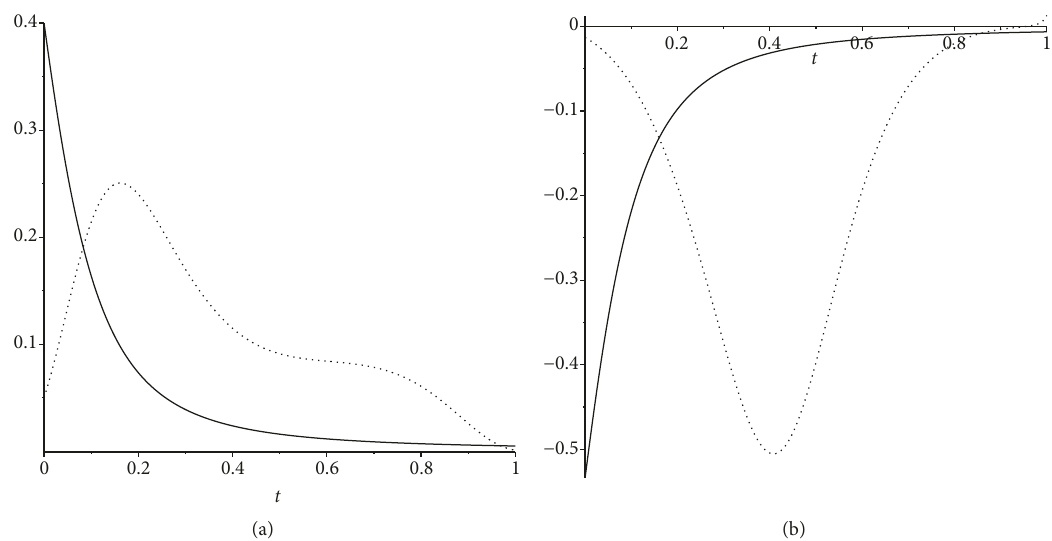
Figure 4: Parameters for real parts of cubic isotropic fractional-rational curves, constructed on the basis of the deformation of a flat curve. Solid line corresponds to the isotropy condition and dotted line to its absence. (a) Curvature. (b) Torsion.